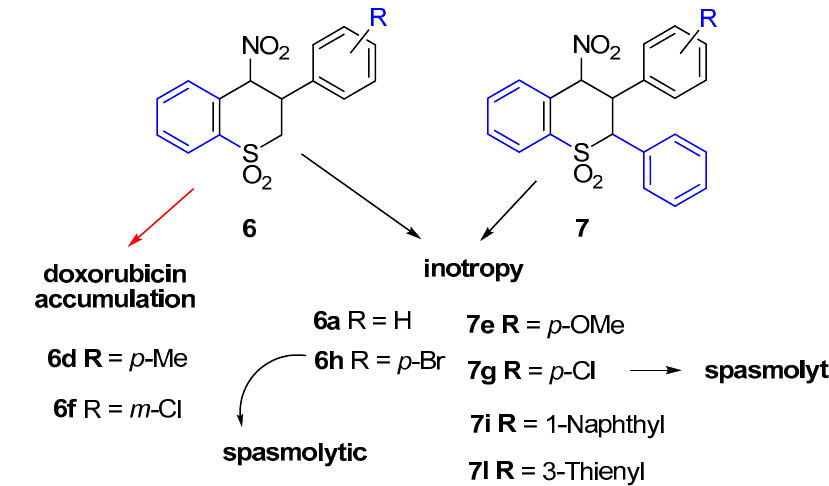
Figure 6. Highlights in structure/activity relationship.